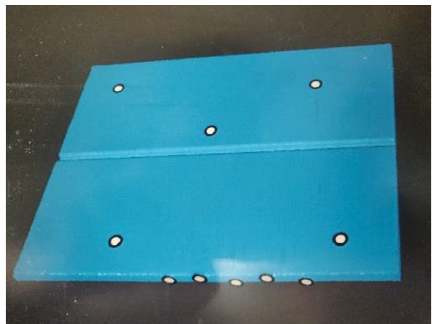
Figure 4: Scanned model